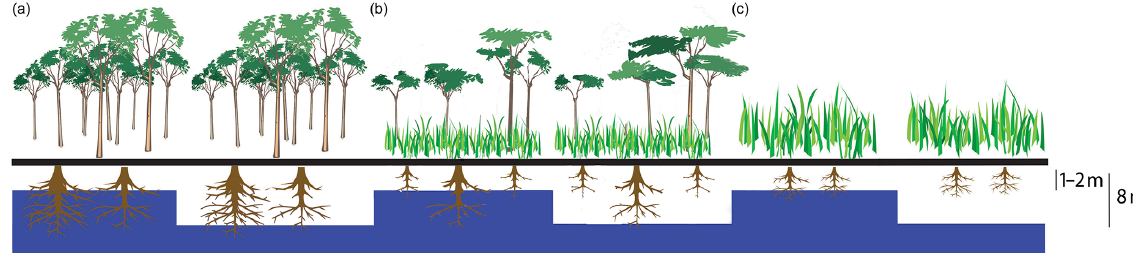
Figure 2. Diagram showing that forest (a) root depth can reach until the saturated zone in both shallow ( < 2m) and deep ( > 8m) WTD, savanna (b) has a mixed rooting depth, with only tree roots reaching deep WTD, and crop (c) vegetation has a low maximum rooting depth – crops having a maximum rooting depth of 2m and savanna having a maximum rooting depth > 10m (Canadell et al., 1996). Shallow roots can reach the saturated zone in shallow WTD ( < 2m); however, they cannot reach the saturated zone in deep WTD ( >